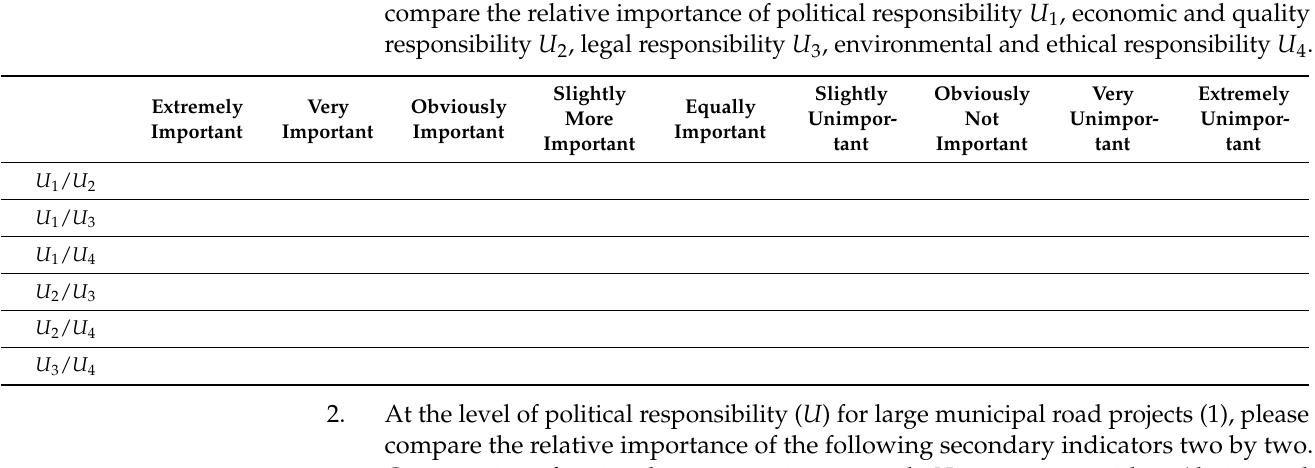
coordination among main government departments, U 14 ; engineering anticorruption, U 15 ; proper handling of relations among people, vehicles, roads and environment, U 16 ; emergency response to public events, U 17 .